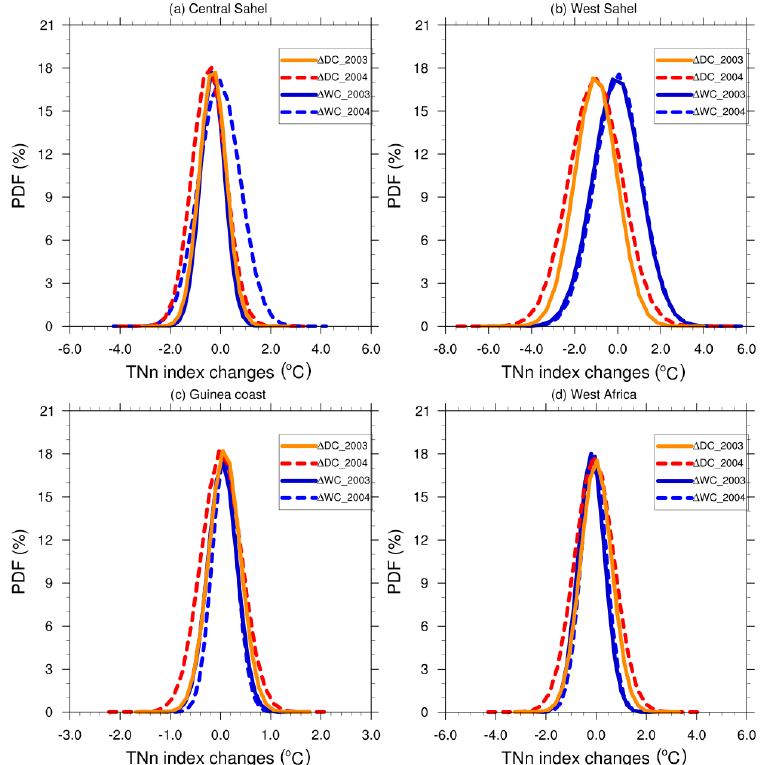
Figure 19. Same as Fig. 14 but for the TNn index.